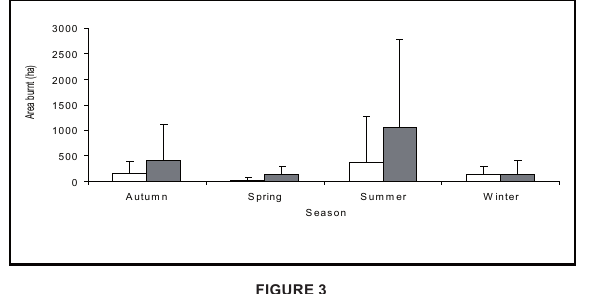
Figure 3 Mean annual area burnt in different seasons in all vegetation types in the Table Mountain National Park in two time periods (unshaded bars = 1970–1988; shaded bars = 1989–2007). Bars are standard deviations from the mean.